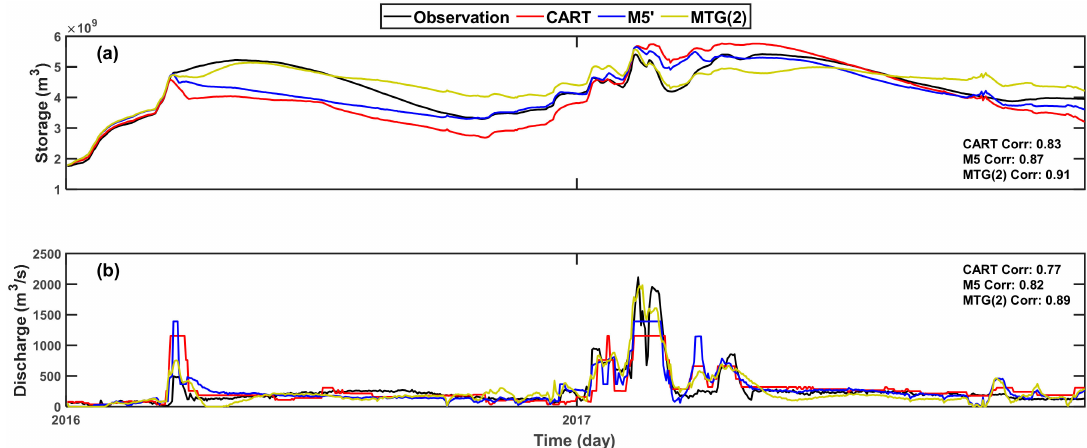
Figure 12. Simulated storage; ( a ) and discharge ( b ) for Shasta dam for years 2016 and 2017 using CART, M5 (cid:48) , and MTG(2)